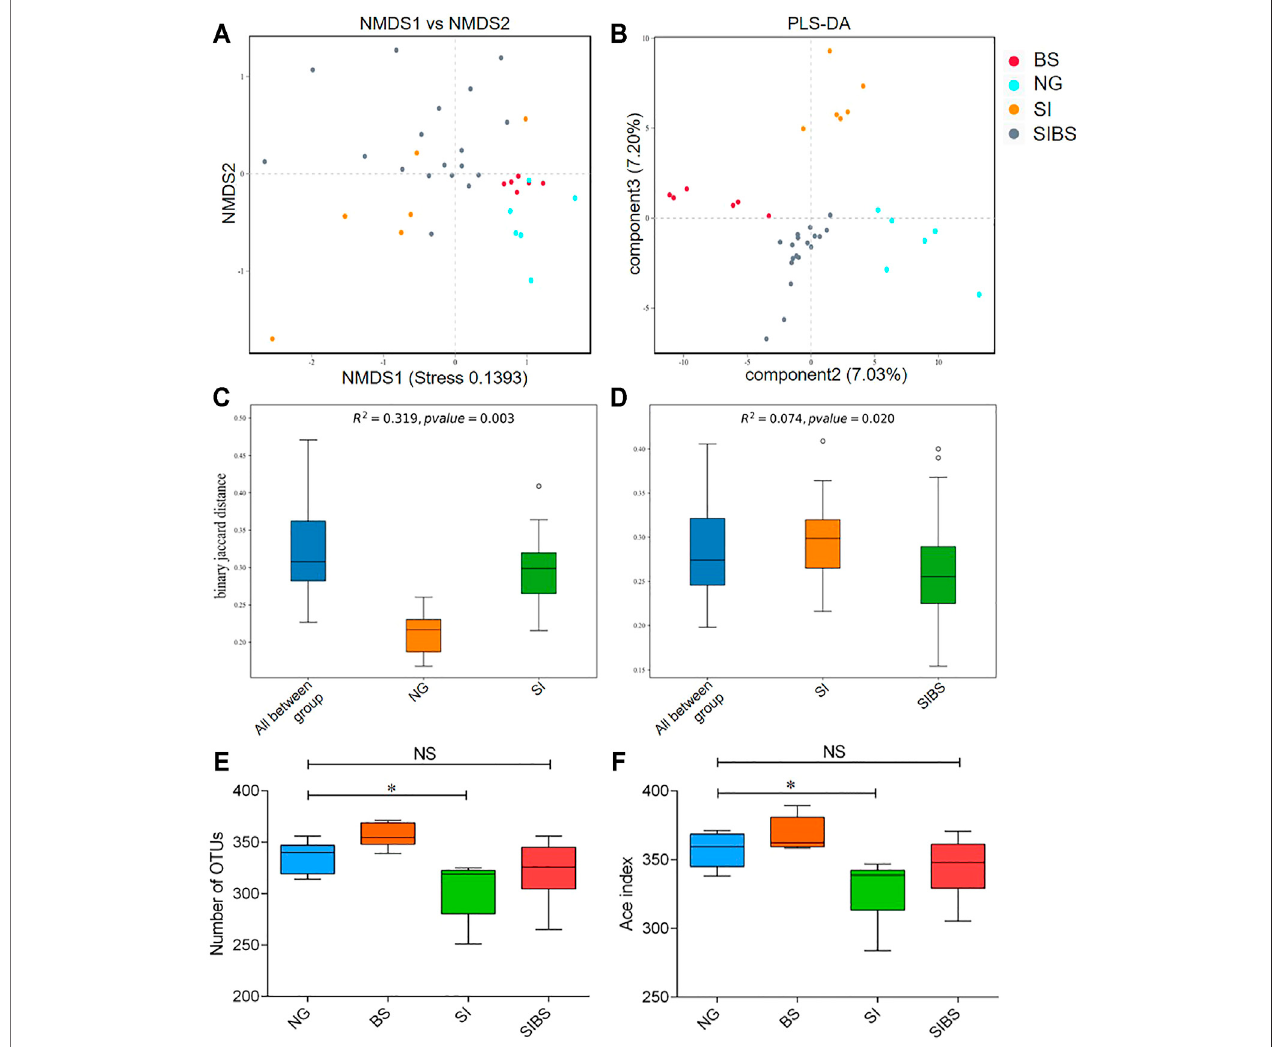
FIGURE 2 | OA B. subtilis modulated community structures and alpha diversity of gut microbiota in S. japonicum – infected mice. (A) NMDS analysis. (B) PLS-DA analysis. (C) The differencein microbial communities between the ND and SI groups using PERMANOVAanalysis. (D) The difference in microbial communities between the SI and SIBS groups using PERMANOVA analysis. (E) OTU number analysis. (F ) ACE index analysis. NG: normal mice with PBS group. BS: normal mice with OA B. subtilis group.SI: S. japonicum – infectedmicegroup. SIBS: S.japonicum – infected mice withOA B.subtilis group. *wasconsidered statisticallysigni fi cant. NS:not statistically signi fi